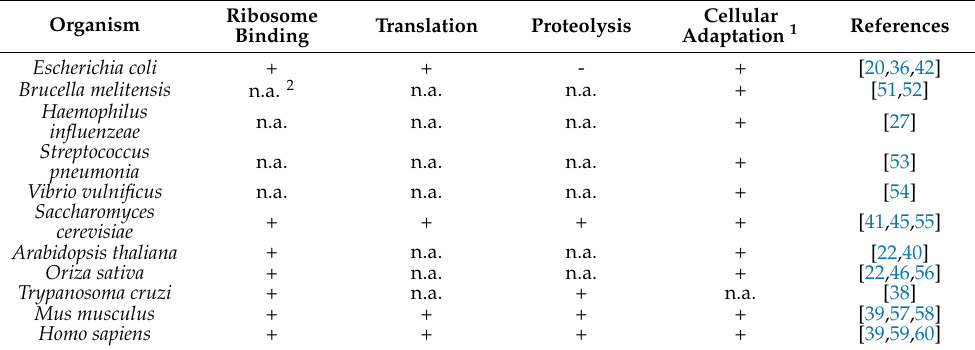
Table 1. Function of YchF/Ola1 in different species.